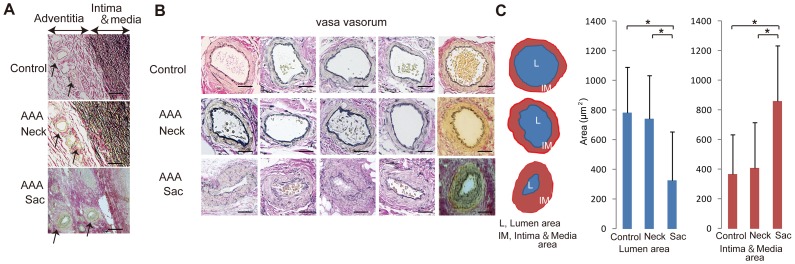
Adventitial vasa vasorum (VV) and its luminal stenosis.(A) Representative adventitial VV with Elastica Van Gieson (EVG) staining. Patent VV in the control and abdominal aortic aneurysm (AAA) neck, andstenotic VV in the AAA sac. Scale bar = 200 μm. (B) Comparison of the luminal and intima–medial areas among the control, neck, and sac adventitial VV. The luminal area was defined as the area enclosed by the intima, while the intima–medial area was defined as the area enclosed between the external elastic laminae and the lumen. Scale bar = 100 μm. (C) Data were obtained from 7 patients and 5 autopsied cases (controls). *P<0.001 indicates a statistically significant difference.